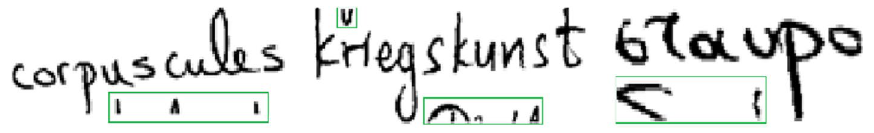
Fig. 15 The green marked portions are results of faulty word segmentation using the ground truth information of the ICFHR 2014 H-KWS com- petition Modern dataset